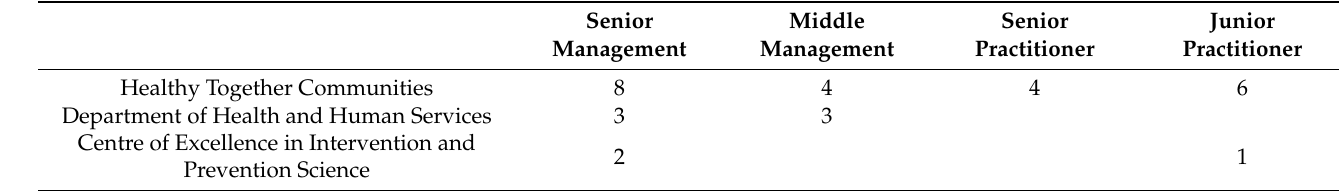
Table 1. The organizational positions of the interview participants.